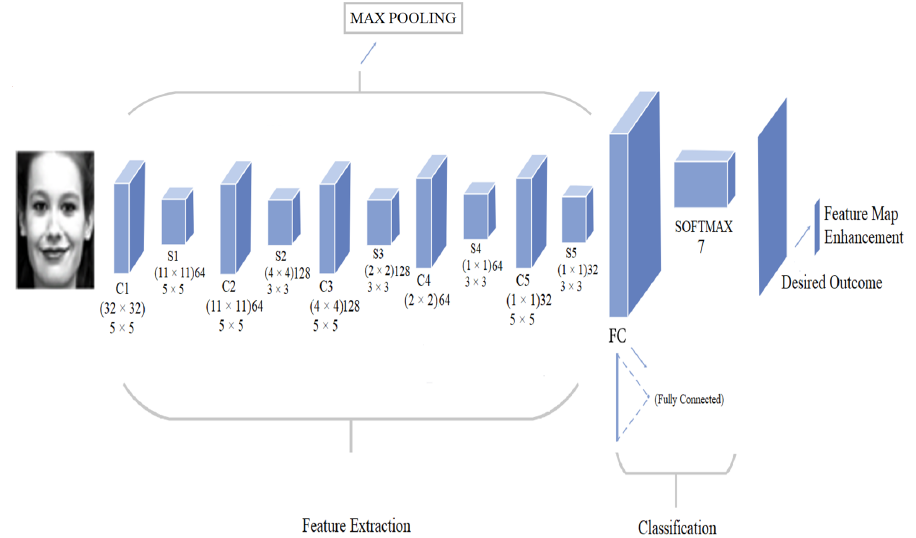
Figure 2. Architecture of the proposed